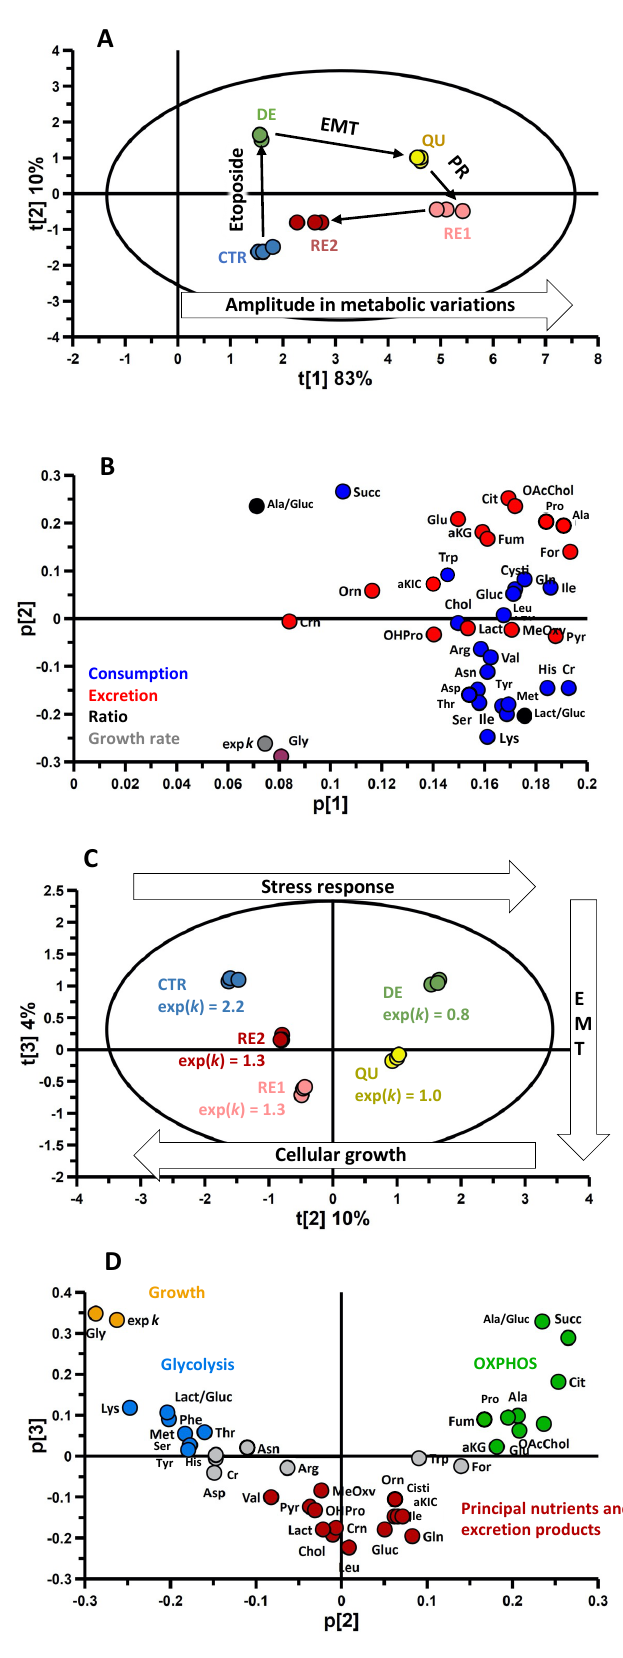
Figure 4. Principal component analysis (PCA)’s score plots of t[1] vs. t[2] (A) and t[2] vs. t[3] ( C ) calcu- lated with the cellular ERs and the metabolic indicators (exp( k ), lactate/glucose, and